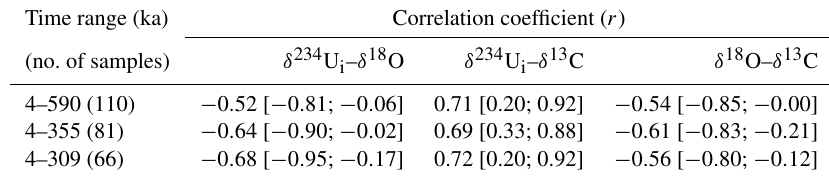
Table 2. Correlation coefficient ( r ) with the 95% calibrated confidence intervals (in brackets) for pairs of δ 18 O, δ 13 C, and δ 234 U i .